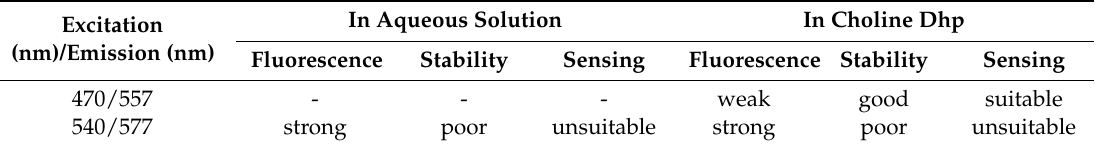
Table 2. A comparison of fluorescent properties of 3endC12-Ag NCs between the aqueous solution and choline dhp.